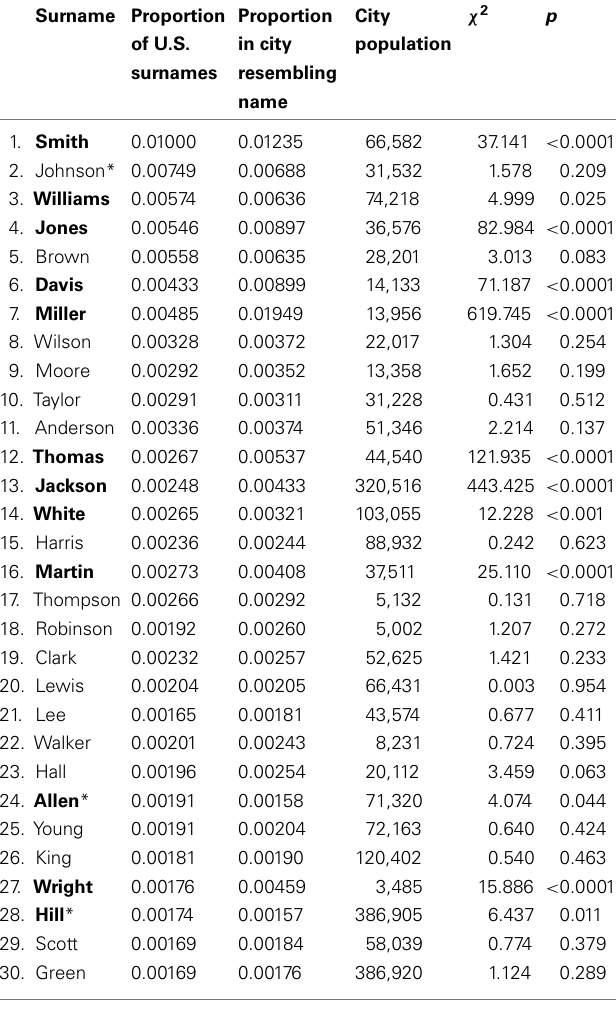
Table 2 |The surname cities data set from Pelham et al., 2003,Table